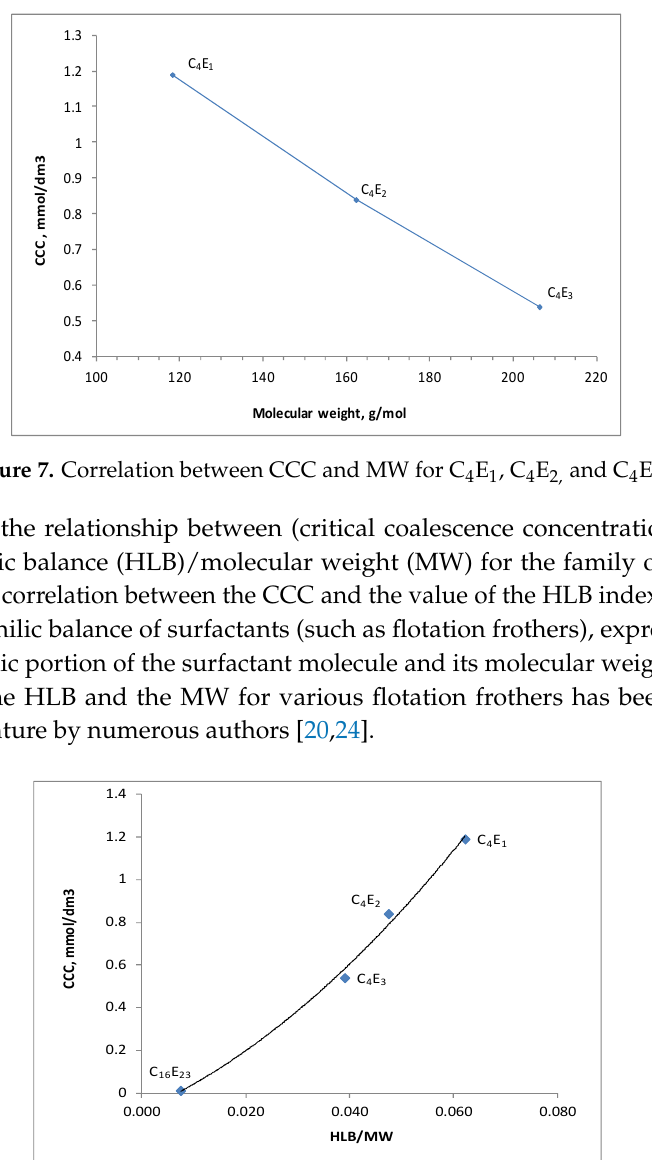
Figure 6. Effect of a number of (EO) groups per molecule on CCC values for the polyglycol frothers.